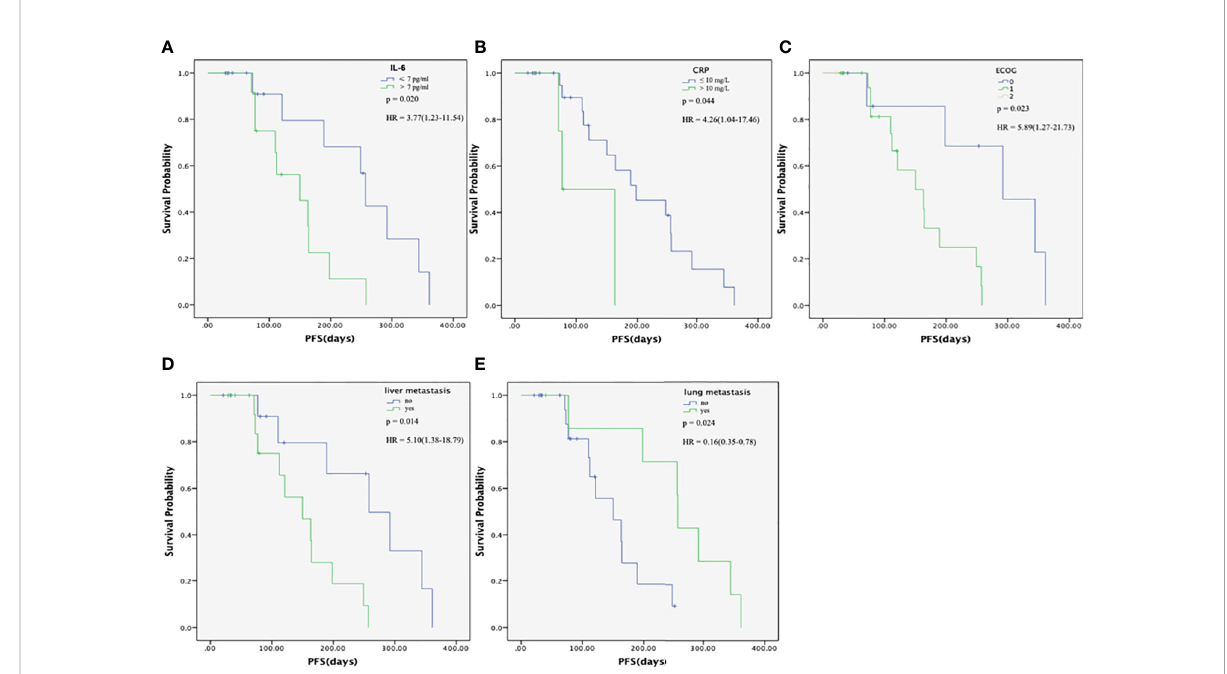
FIGURE 4 Progression-free survival (PFS) of patients with metastatic pancreatic cancer (mPC) treated with the modi fi ed FOLFIRINOX. (A) PFS in the interleukin (IL)-6-high and – low groups. The median PFS in the IL-6-low group was 257 (95% CI: 237-276) days, which was signi fi cantly higher than that in the IL-6-high group (median PFS, 150 days; 95% CI:47-252, P=0.020). (B) PFS in the C-reactive protein (CRP)-high and -low groups. The median PFS in the CRP-low group was 198 (95% CI: 42-353) days, which was signi fi cantly higher than that in the CRP-high group (median PFS, 163 days; 95% CI:28-297, P = 0.044). (C) PFS in the different ECOG groups. The median PFS was 292 (95% CI: 151-432) days and 150 (95% CI:81-218) days for ECOG score 0 and 1 group, respectively. (D) PFS according to the presence of liver metastasis. The median PFS in the non- liver metastasis group was 258 (95% CI:143-372) days, which was signi fi cantly higher than that in the liver metastasis group (median PFS, 150 days; 95% CI: 84-215, P = 0.014). (E) PFS, according to the presence of lung metastasis. The median PFS in the lung metastasis group was 258 (95% CI:255-260) days, which was signi fi cantly higher than that in the non-lung metastasis group (median PFS, 150 days; 95% CI: 86-213 P = 0.024). The PFS was calculated using the Kaplan-Meier method.